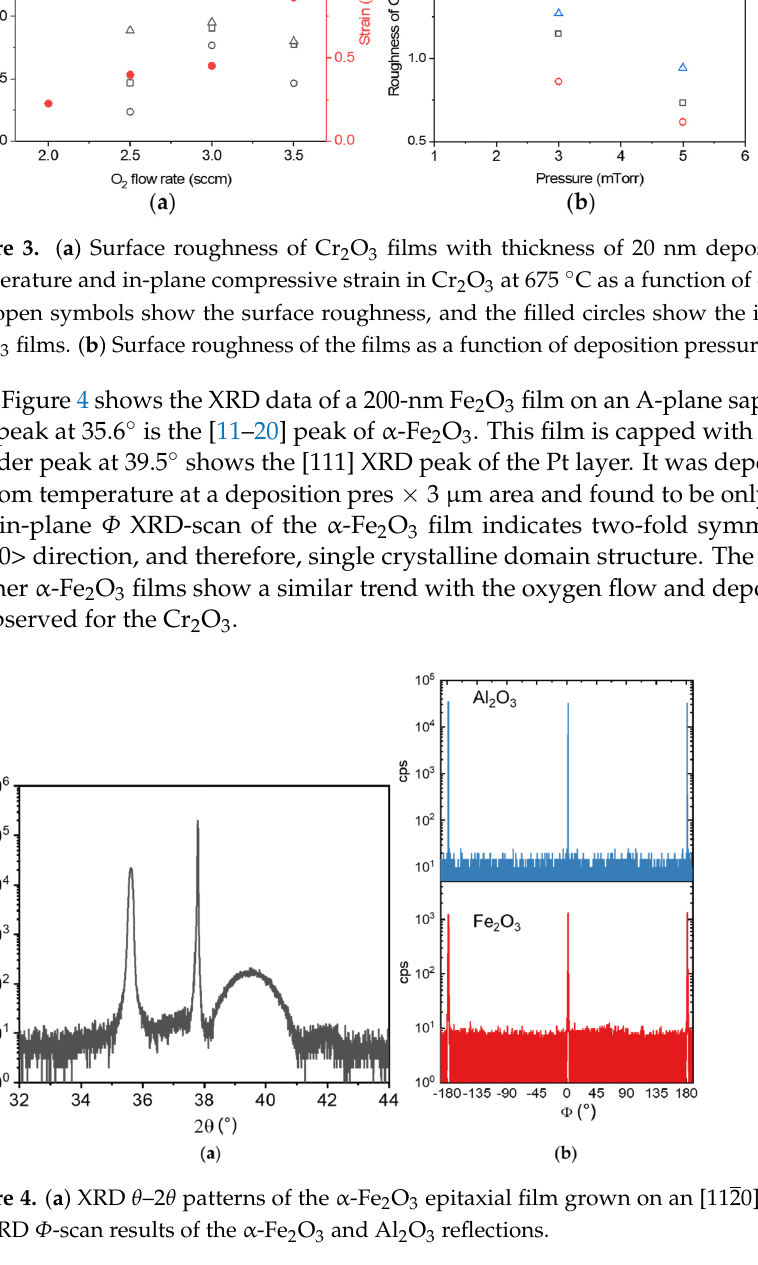
Figure 5. Atomic force micrograph of 200 nm thick α -Fe 2 O 3 film. 3.2. Magnetic Properties Cr 2 O 3 and α -Fe 2 O 3 are both antiferromagnetic materials. To confirm the absence of any residual magnetism in Cr 2 O 3 and α -Fe 2 O 3 films, SQUID measurements were per- formed with magnetic fields of 0.4 and 0.2 T, respectively, applied perpendicular to the A-plane of the substrates. For the SQUID measurement, a 5 × 5 mm sample is loaded in the chamber inside a straw. The sample plane is perpendicular to the magnetic field. Fig- ure 6 shows the magnetization of the epitaxial oxide films as a function of temperature.